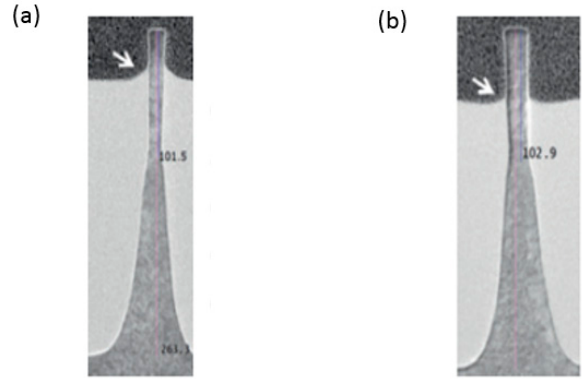
Figure 18. STI footing by wet etching with ( a ) an oxide foot at the bottom edge and ( b ) footing is reduced and recess control is improved due to digital nature of the etching. Reproduced with permission from [130]. Copyright Solid-State Electronics, 2012.